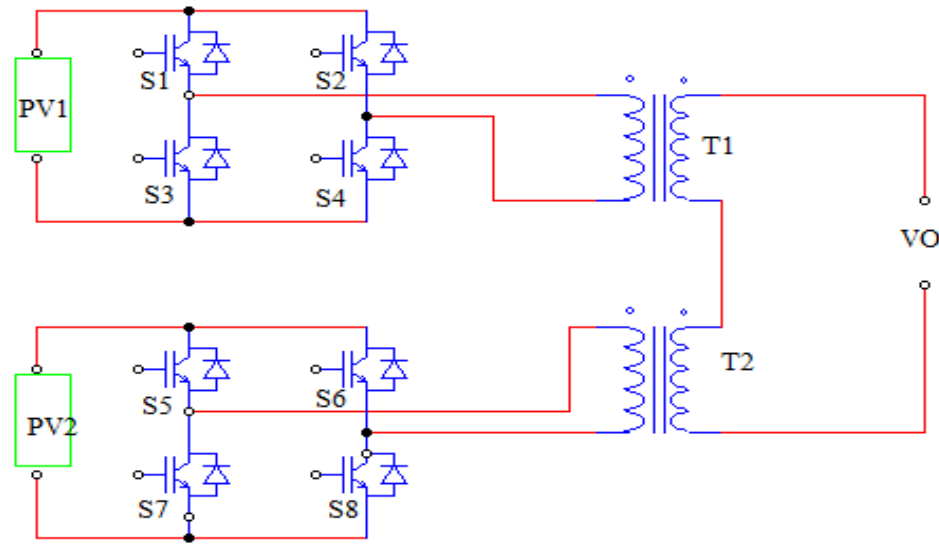
Figure 13. Eight-switch, nine-level topology [62].